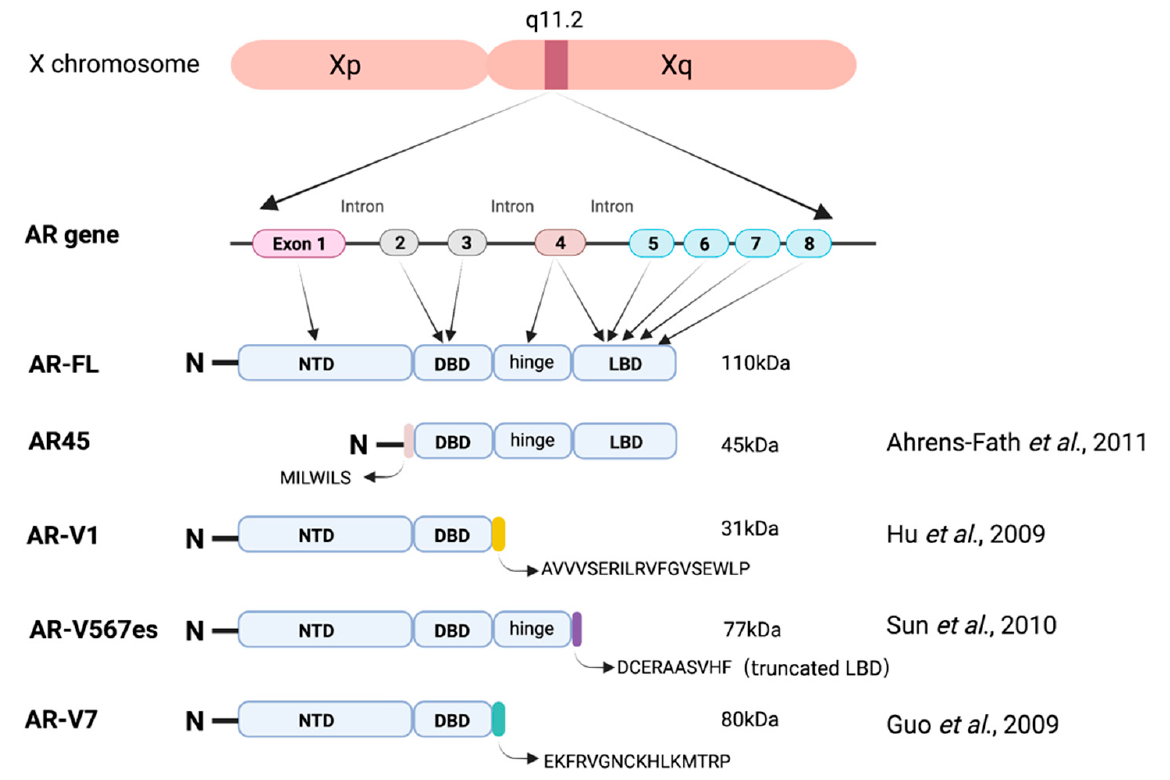
Figure 1. Full-length androgen receptor and its truncated splicing variants. See Refs.